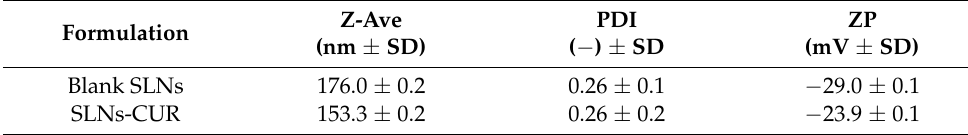
Table 1. The values of Z-Ave, PDI, and Z-potential for unloaded and CUR-SLN recorded at 20 ◦ C. Z-Ave PDI Formulation (nm ± SD) ( − ) ± SD Blank SLNs 176.0 ± 0.2 SLNs-CUR 153.3 ±